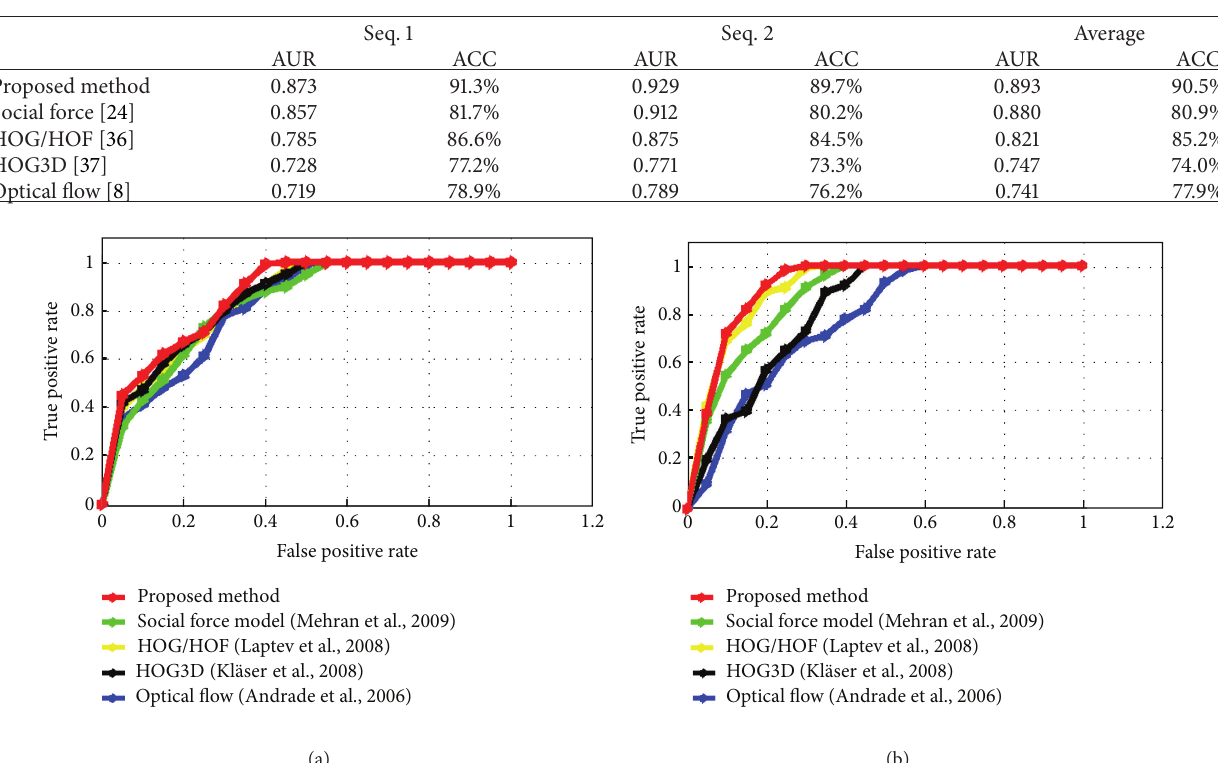
Table 2: Comparison for AUC and ACC of different algorithms.